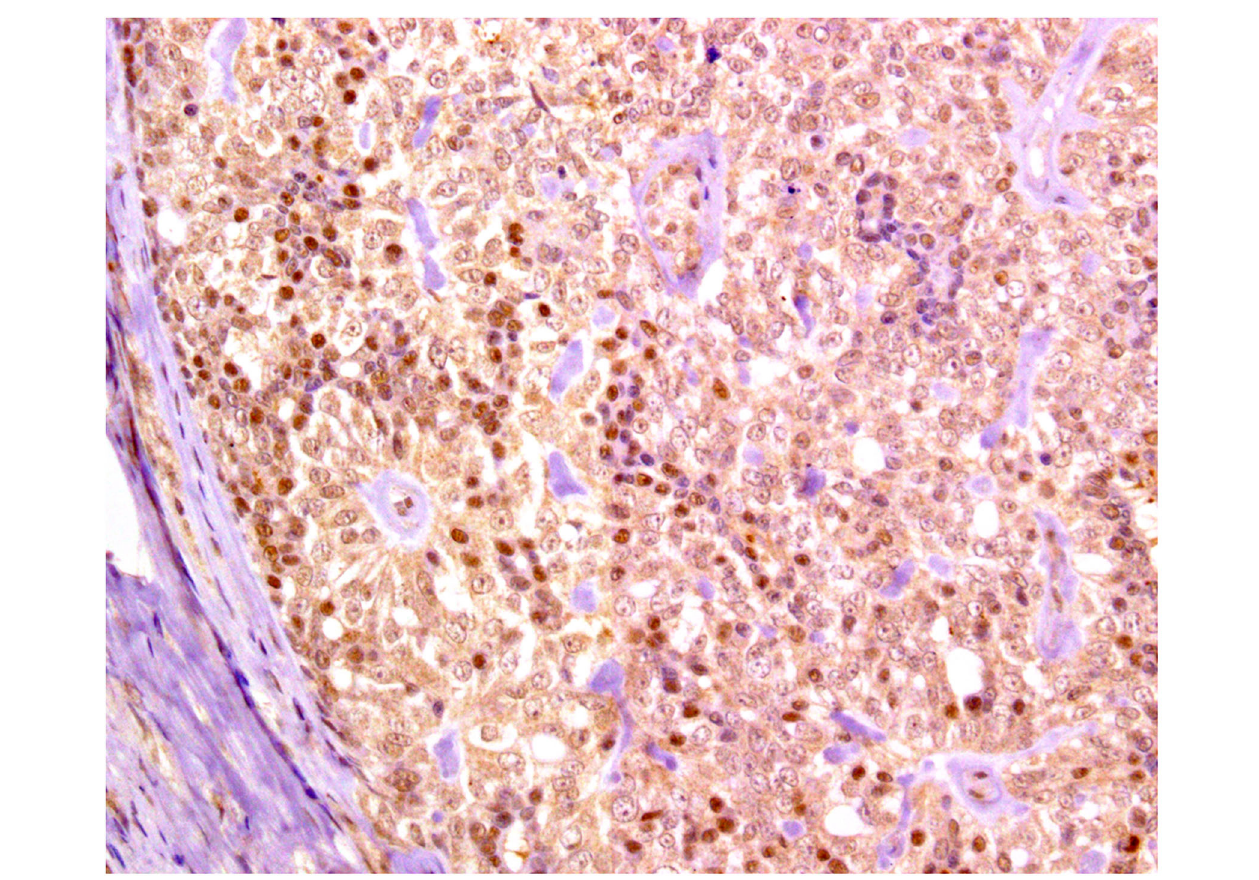
FIGURE 7 | Solid carcinoma, mammary gland, dog. Immunohistochemical nuclear staining of estrogen receptor (ER). Neoplastic cells are positive with different intensities of immunolabeling.